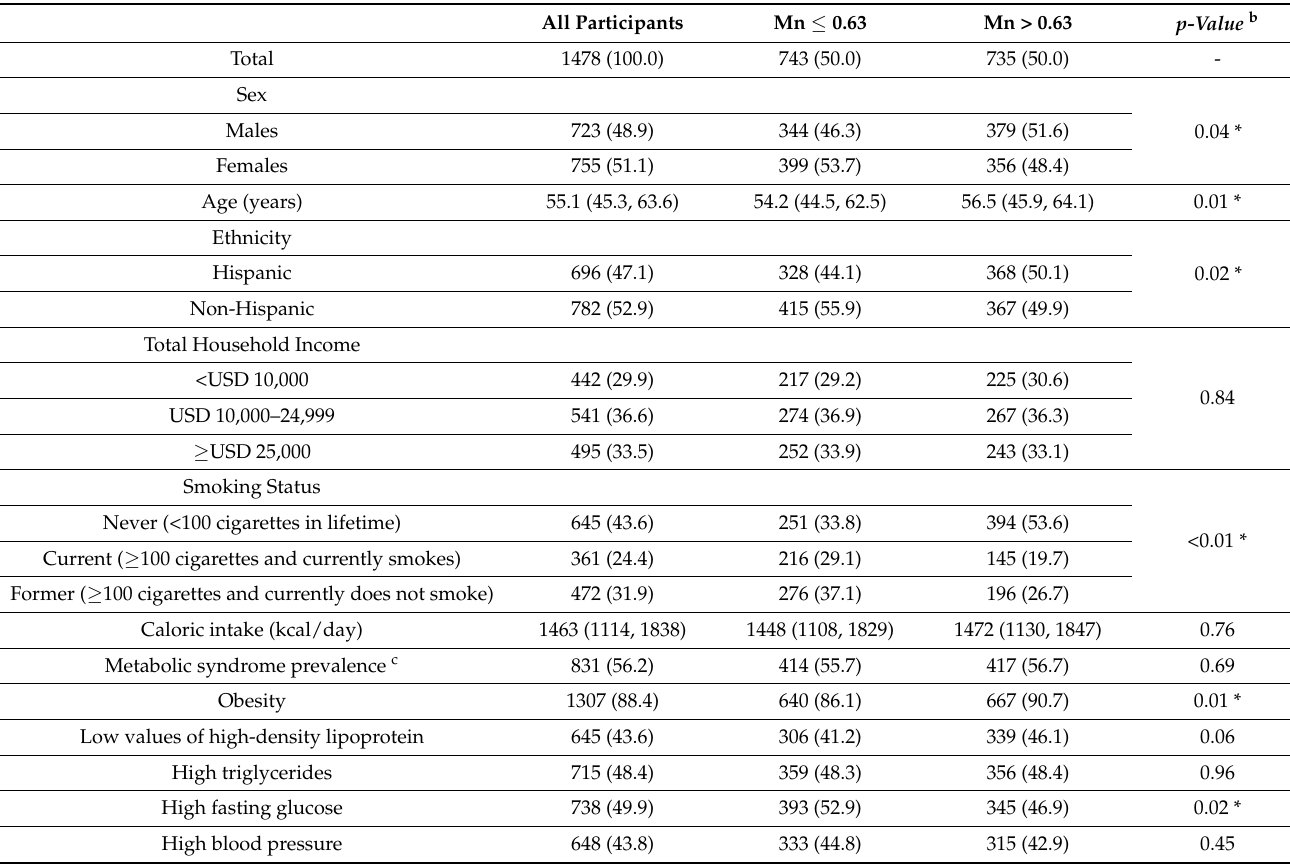
Table 1. Baseline characteristics a of the sample contrasted by the median Mn